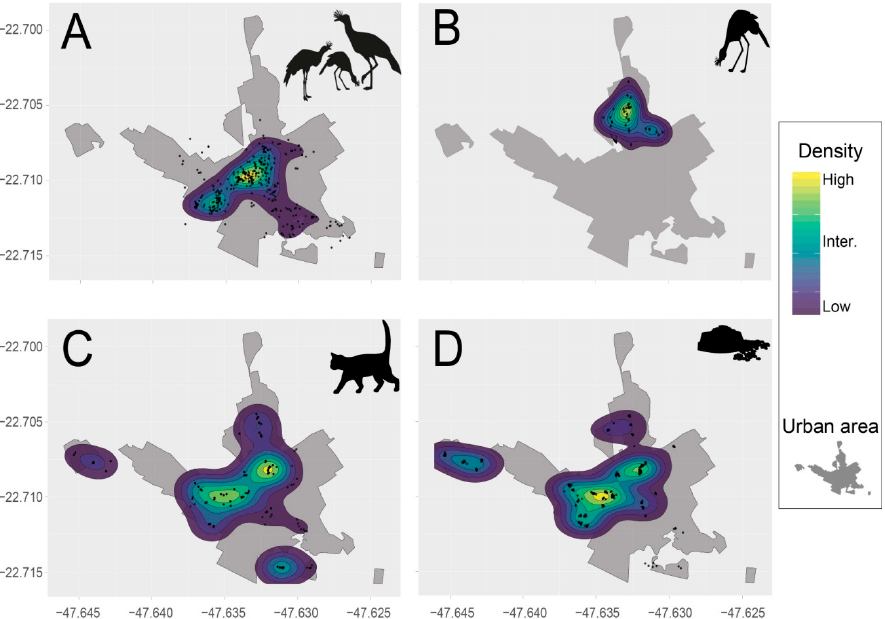
Figure 3. Multi-state ordered density analysis showing the distribution and density of: ( A ) monitored Red-legged Seriema family, ( B ) Seriema individual “ID4”, ( C ) domestic cats, and ( D ) cat-feeding points, within the “Luiz de Queiroz” campus.